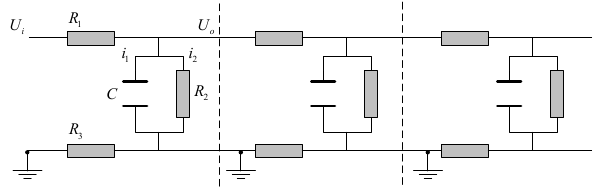
Figure 4. The cable model without considering the extracellular potential.